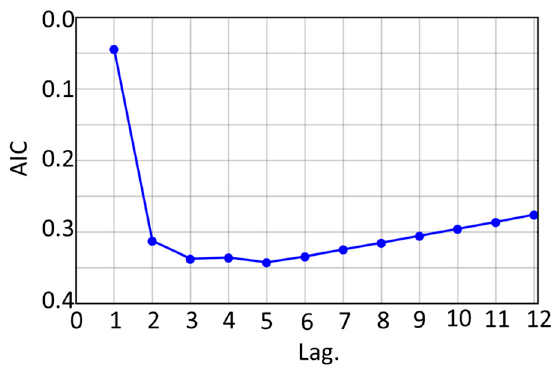
Figure 5. Relation of Lagged time and AIC.